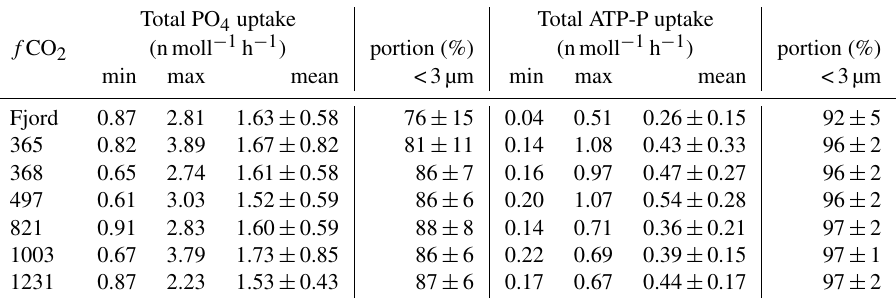
Table 4. PO 4 - and ATP uptake rates in the fjord and in the mesocosms. Minimum, maximum and mean values as well as the contribution of the size fraction <3µm to the total activity are given for the whole period of investigation (each: n = 16 for PO 4 and n = 6 for ATP uptake). Total PO 4 uptake Total ATP-P uptake f CO 2 (nmoll − 1 h − 1